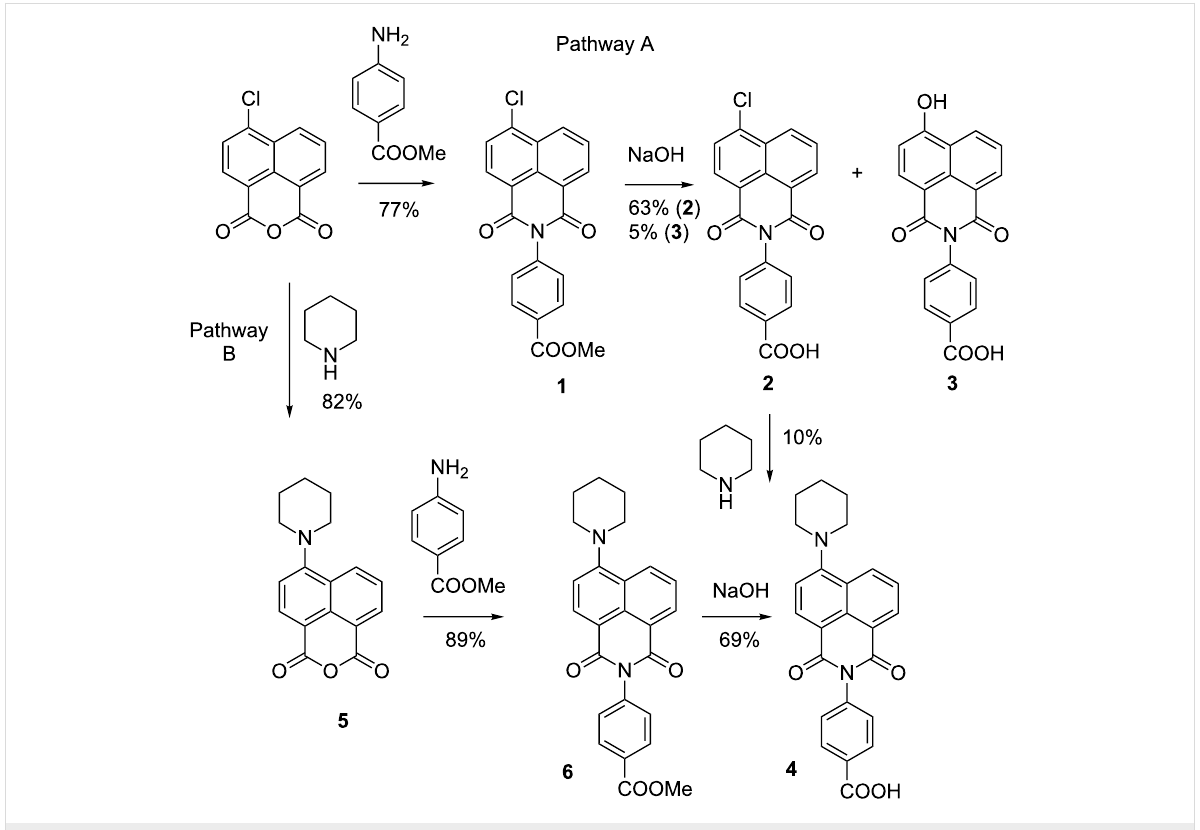
Scheme 1: Synthesis and structures of